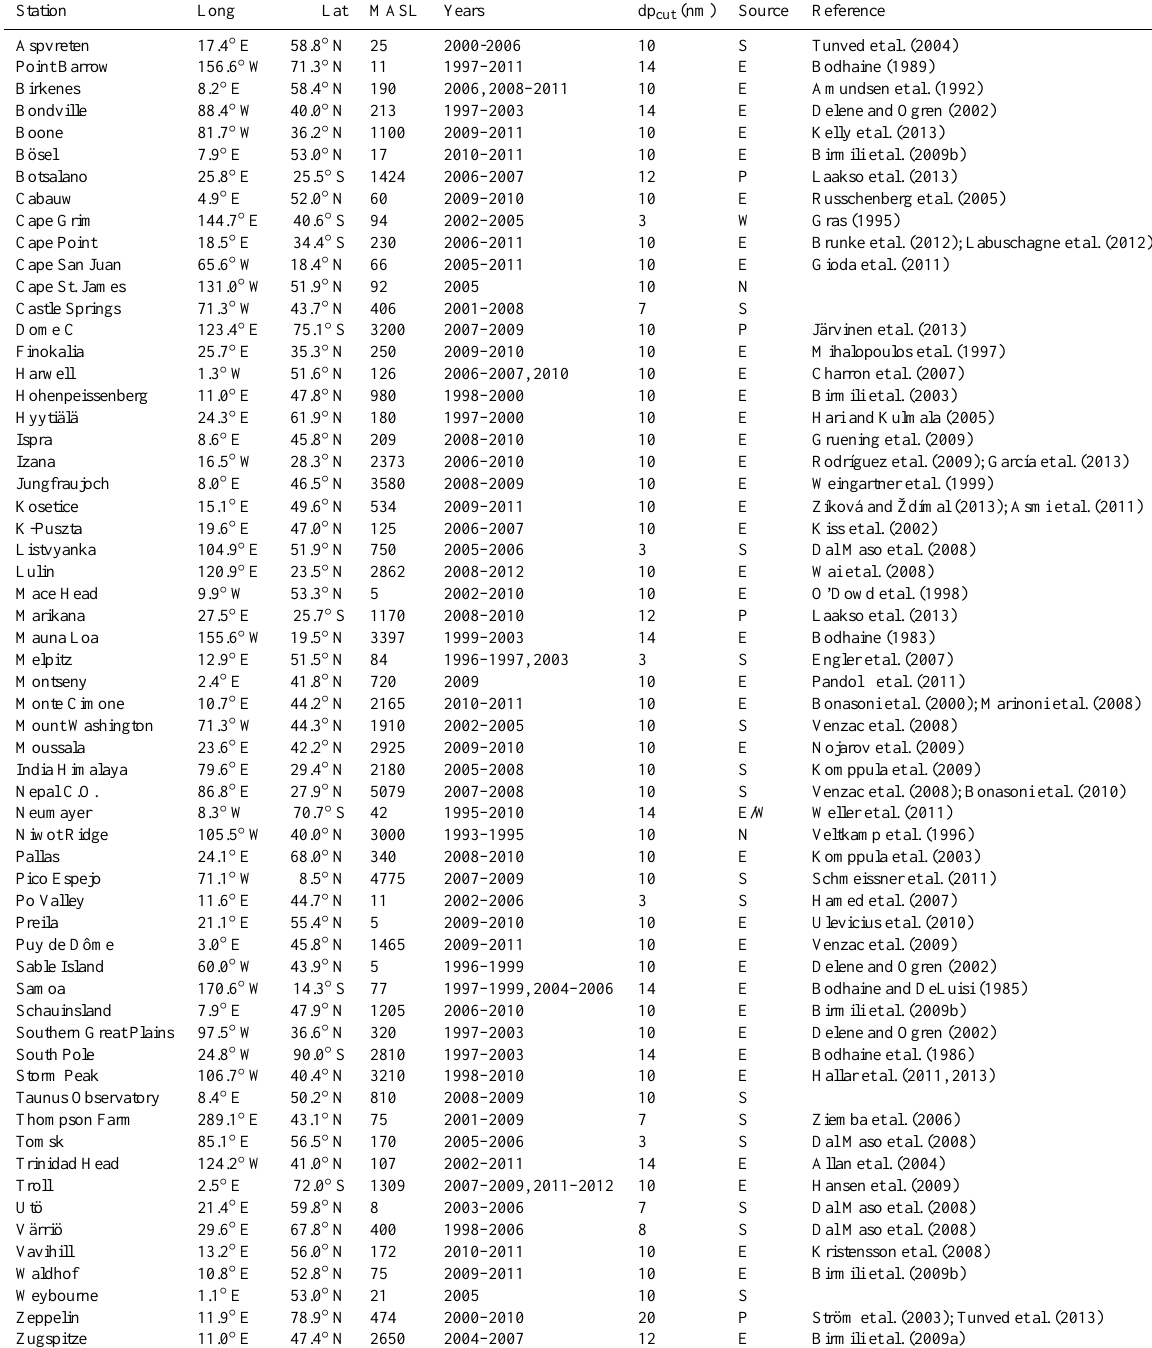
Table 4. Description of surface sites used in the model evaluation. Source of data: EBAS (E), WDCA (W), NOAA (N), Spracklen et al. (2010) (S), published data (P). The minimum cut-off diameter dp cut as well as covered measurement years are indicated for each station. Station Long Lat MASL Years dp cut (nm) Source Reference Aspvreten